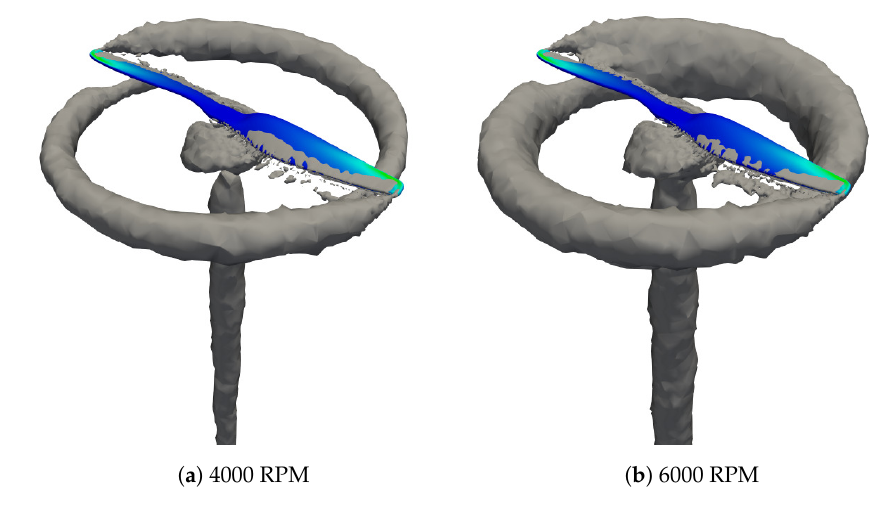
Figure 10. Q-Criterion Contours (15,000 s − 2 ).